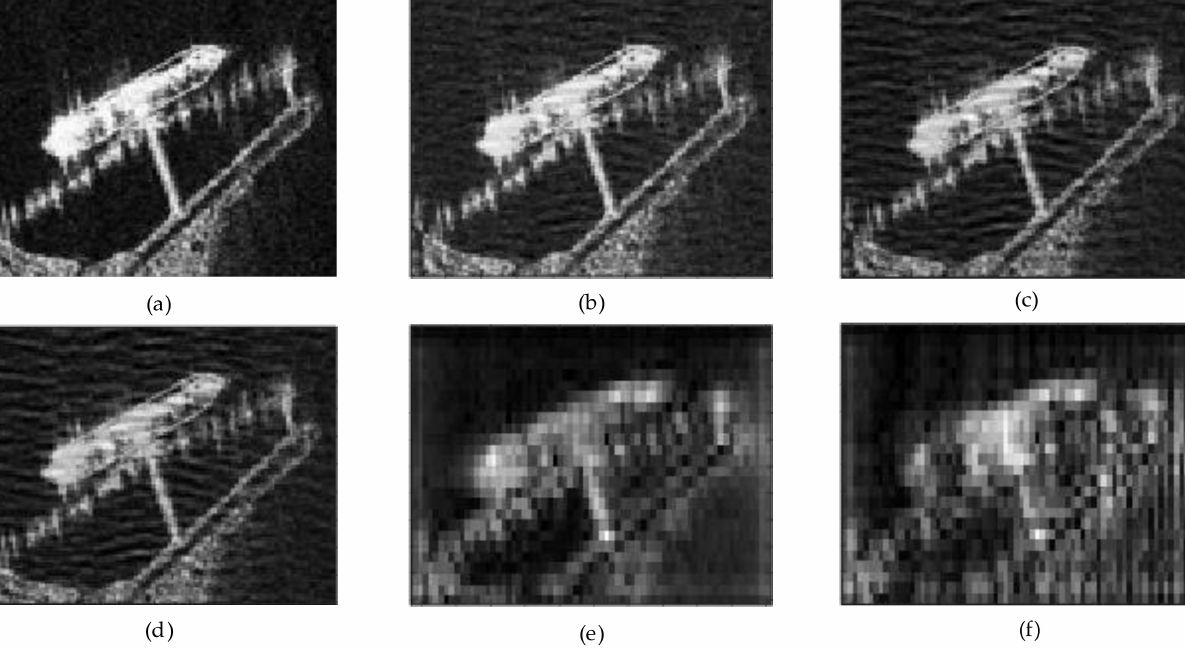
Figure 7. Inshore ship target imaging results. ( a ) is original ship target, ( b ) is our proposed method with L = 3, ( c ) is our proposed method with L = 8, ( d ) is our proposed method with L = 11, ( e ) is ISTA method and ( f ) is Fast ISTA